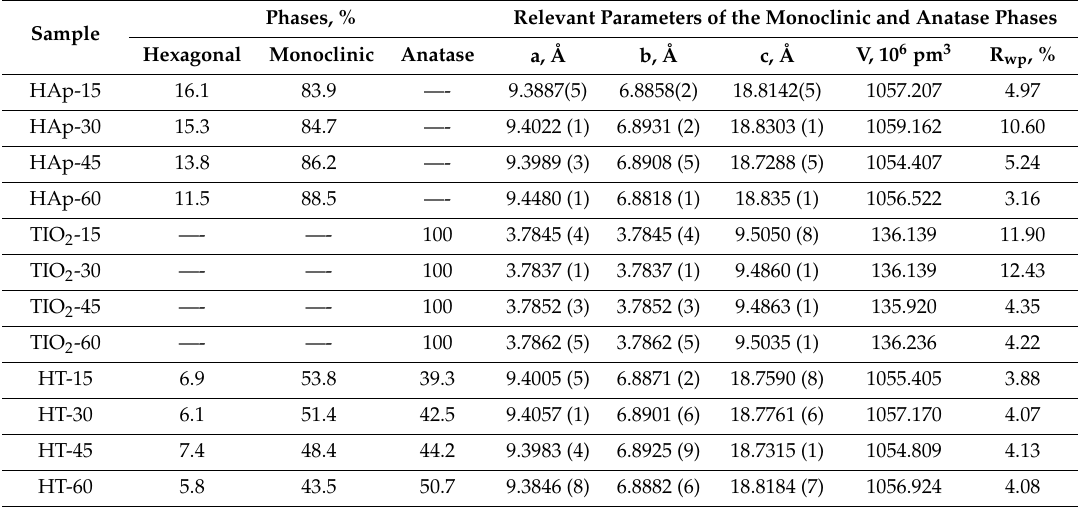
Table 1. Main crystalline parameters of HAp, TiO 2 , and HAp/TiO 2 nanocomposite samples.